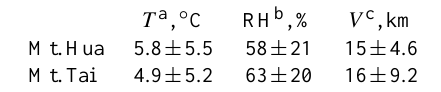
Fig. 1 Sampling sites of Mt. Hua and Mt. Tai in East Asia